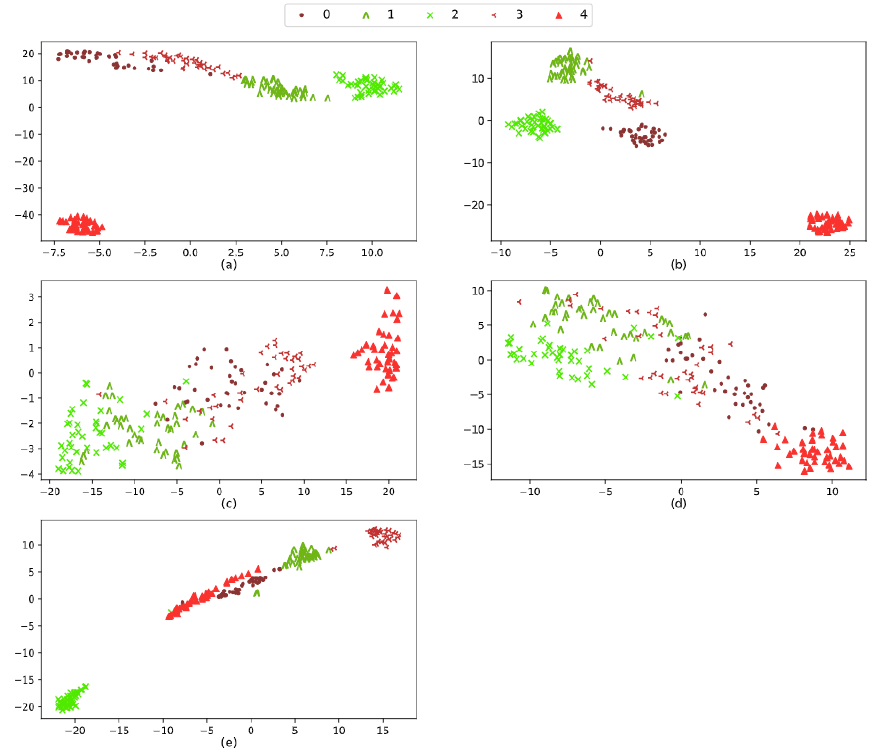
Figure 15. Visualization results of t-SNE dimensionality reduction. ( a , b ) are the t-SNE visualization results of the weighted data of the vertical sensor and horizontal sensor respectively, ( c , d ) are the t-SNE visualization results of the unweighted data, ( e ) is the t-SNE visualization result of the weighted data of all sensors.